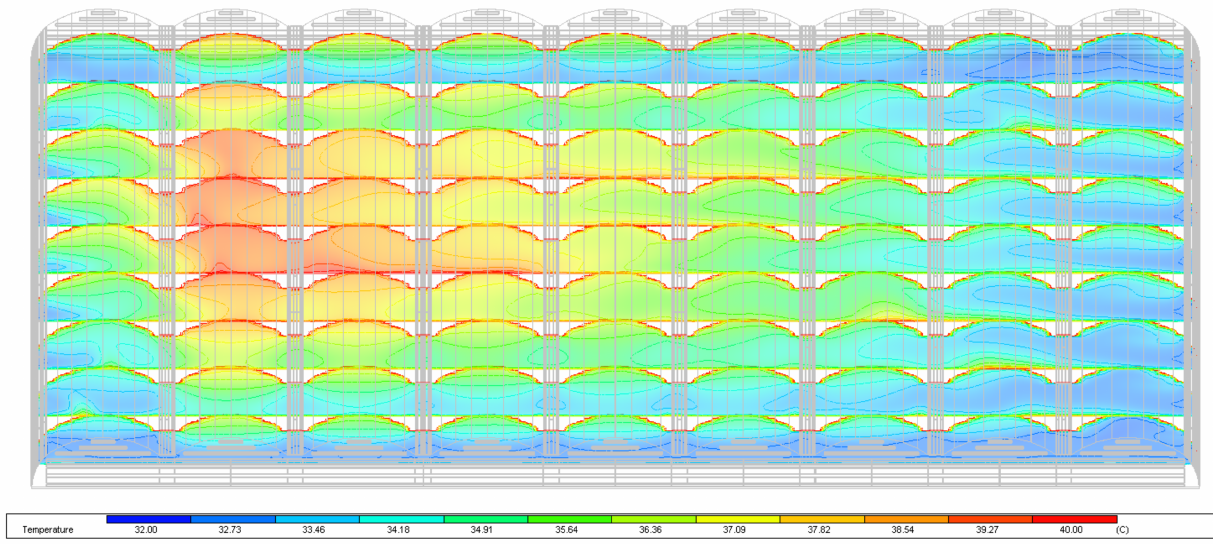
Figure 14. Temperature cloud map of the crossed multi-arch greenhouse (with an in-greenhouse ventilation channel) (outdoor wind speed 1 m/s, outdoor temperature 32.7 ◦ C).